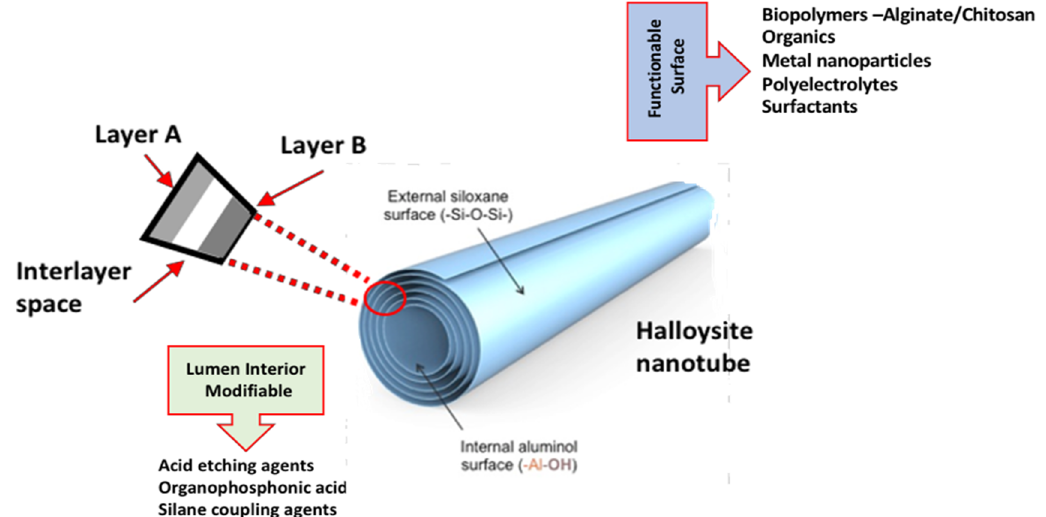
Figure 2. The structure of halloysite and its potential for surface modification.